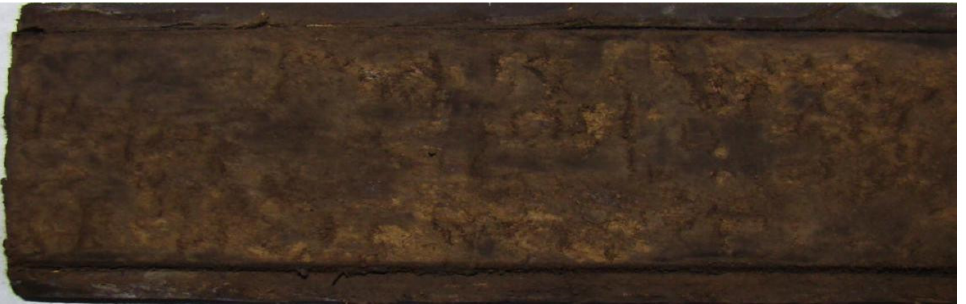
Figure 14. Surface state of insulation layer after second ablative experiment (gas phase velocity was 2 m/s).